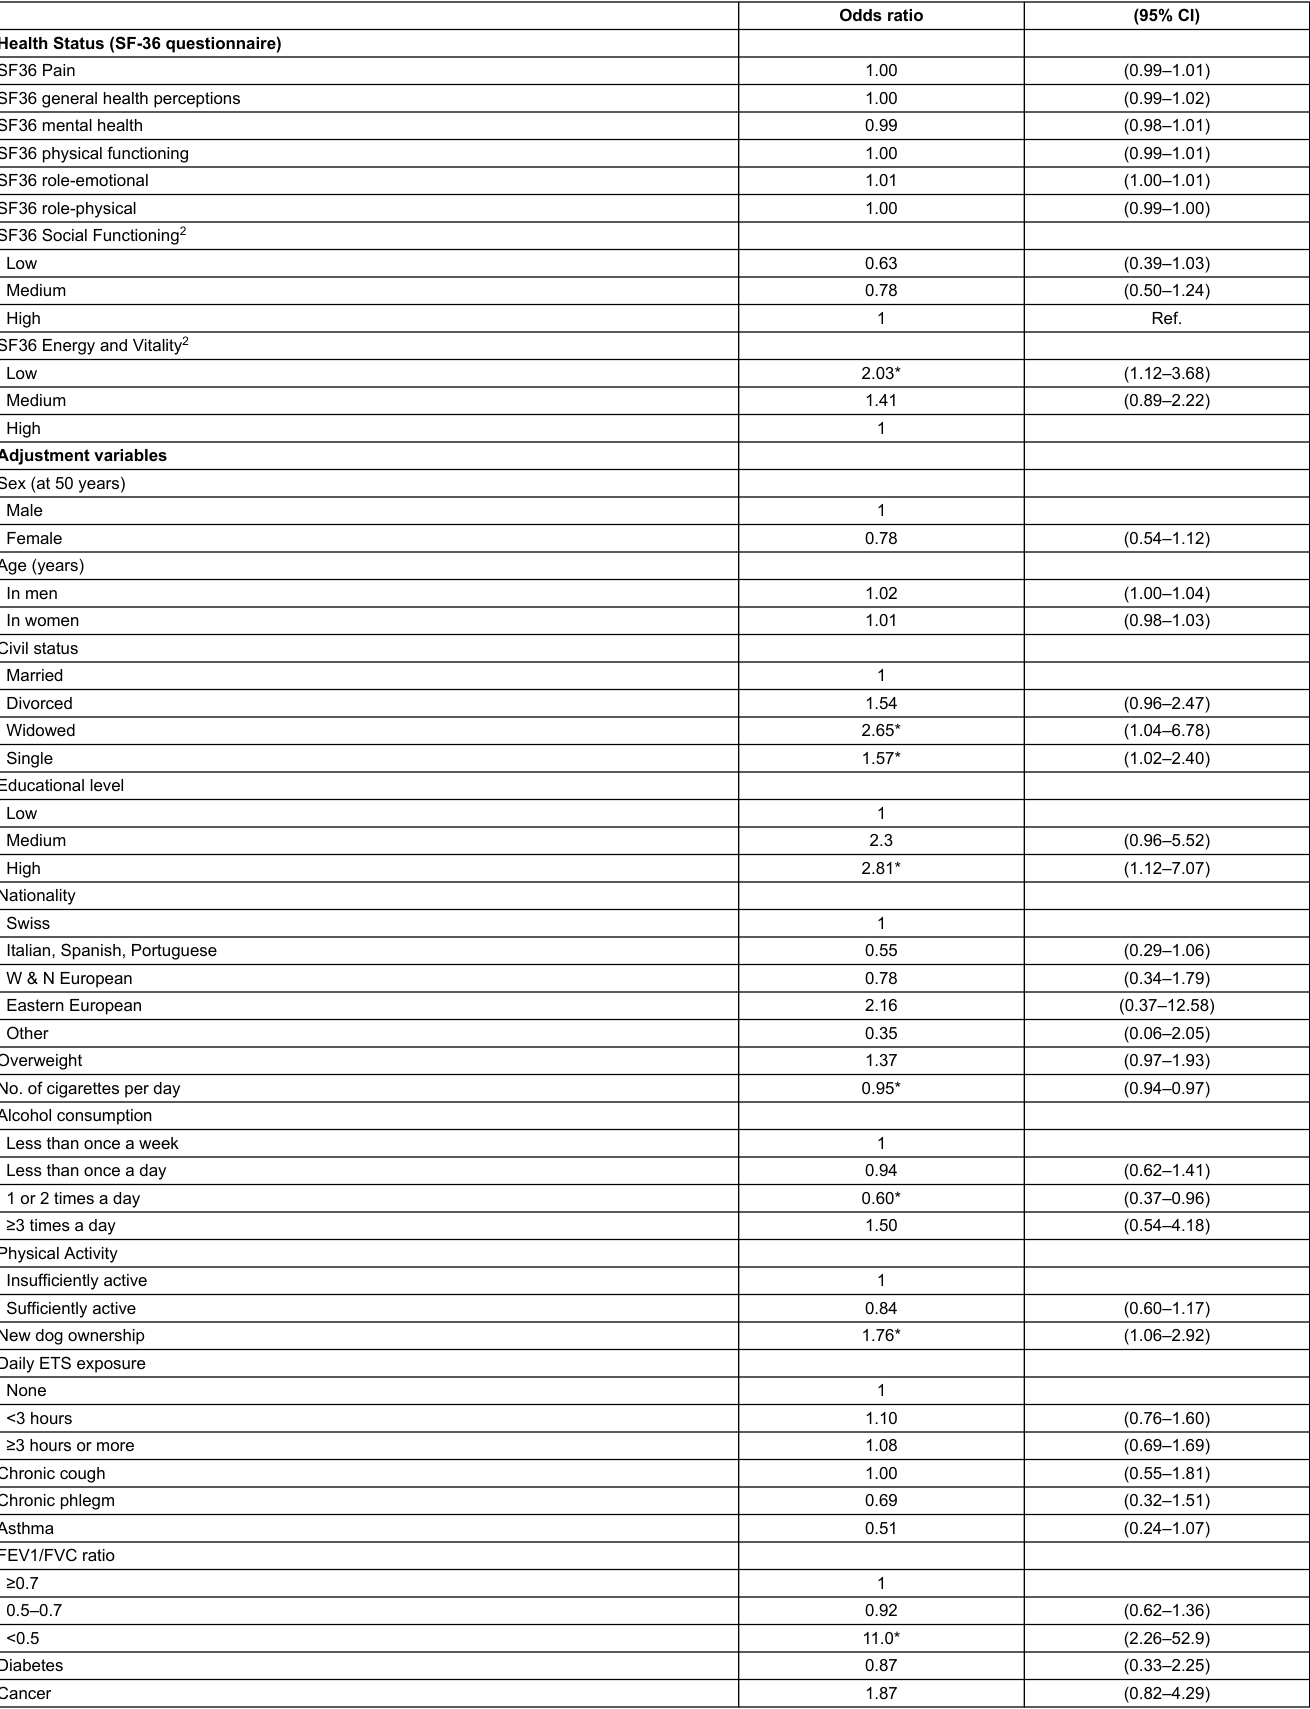
Table S3: Estimated independent associations of smoking cessation between SAPALDIA2 (2002) and SAPALDIA3 (2010/11) with indicators of health related quality of life (SF36) assessed at SAPALDIA2 (n = 880) 1